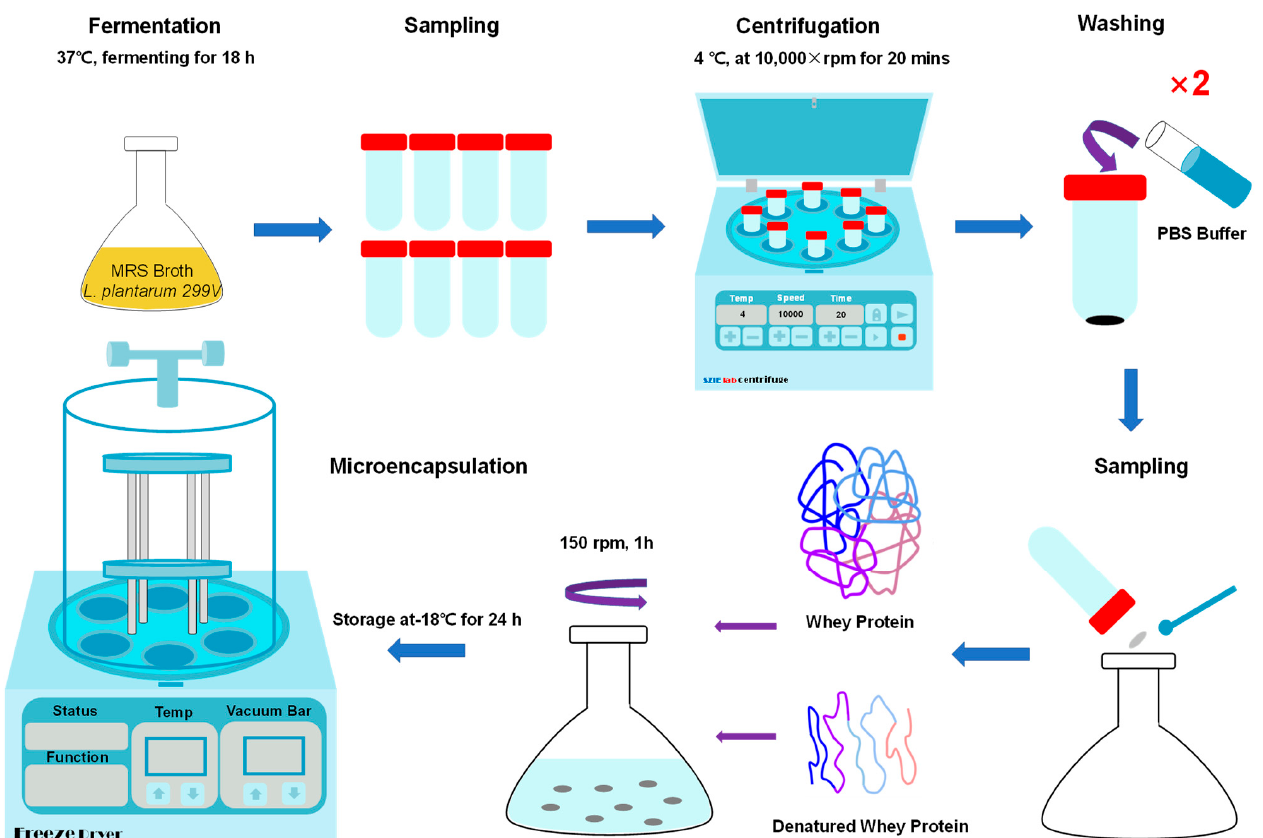
Figure 1. Scheme of microencapsulation process of L. plantarum 299v with proteins by lyophiliza ‐ tion .